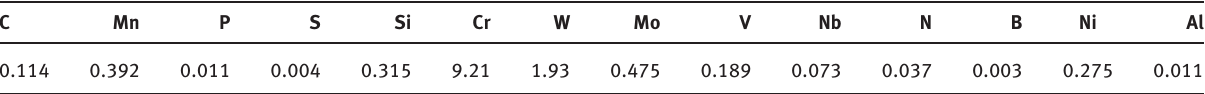
Table 1: Chemical composition (wt%) of the steel studied.